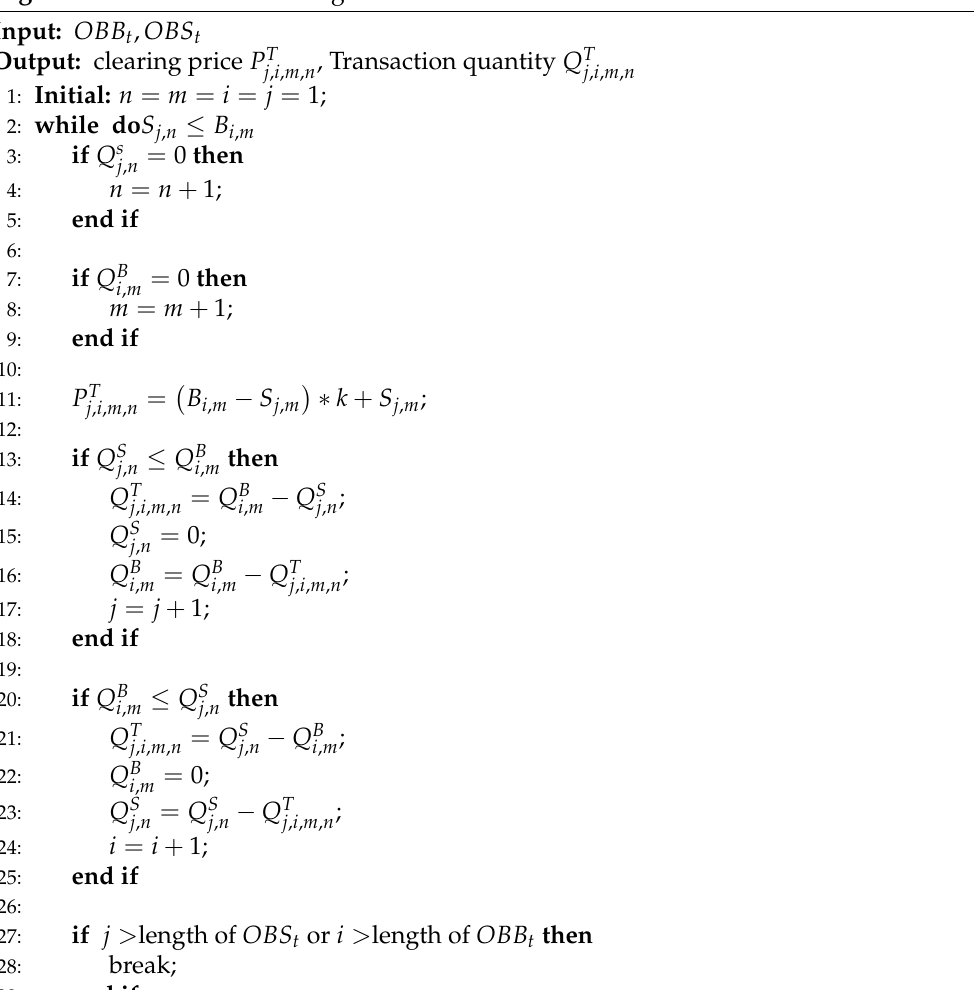
Algorithm 1 The transaction algorithm of t